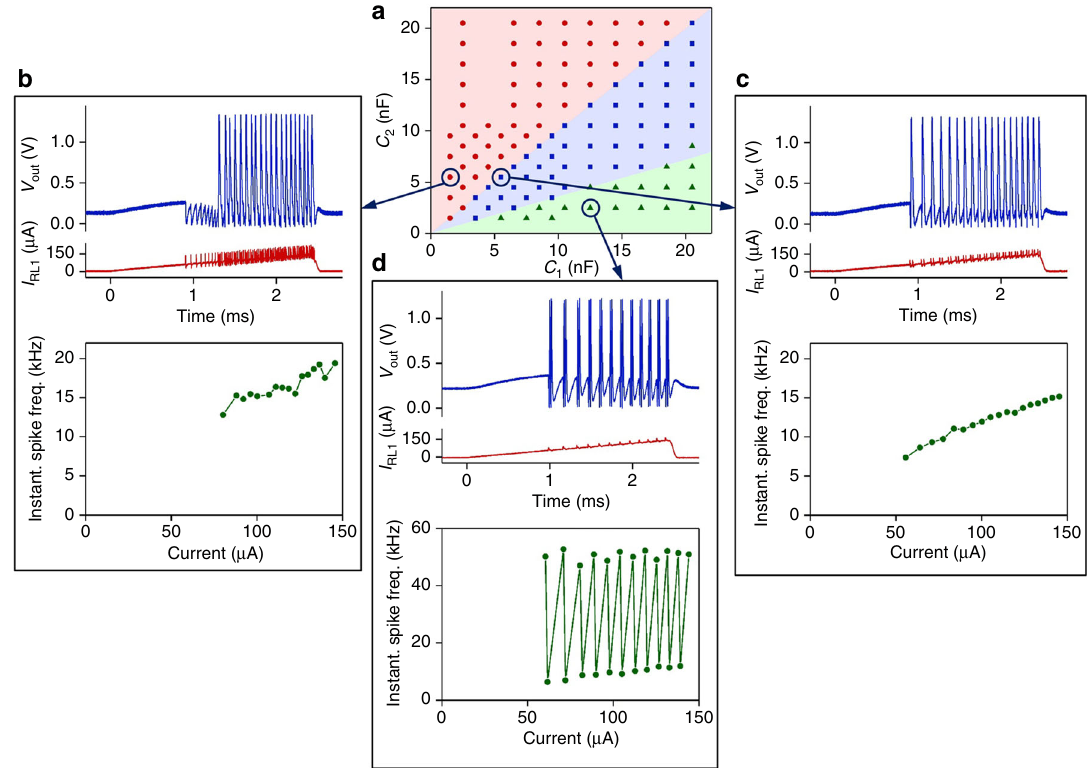
Fig. 5 Capacitance-dependent operating regimes in a tonic VO 2 active memristor neuron. a Diagram of operating regimes determined by the values of C 1 and C 2 membrane capacitors. When C 2 > C 1 , the neuron exhibits Class 2 excitable spiking and subthreshold oscillations (see ( b )). When C 2 < C 1 , the neuron exhibits Class 1 excitable spiking (see ( c )). When C 2 < 0.35 C 1 , the neuron exhibits Class 1 excitable bursting (see ( d )). Various combinations of C 1 and C 2 are sampled (colored dots) by measuring time dependence of neuron output with a linearly ramped input current. ( b – d ) Typical neuron input and output vs. time (top panels), and the current-dependence of instantaneous spike frequency (bottom panels) sampled from Class 2 excitable spiking, Class 1 excitable spiking, and Class 1 excitable bursting regimes,